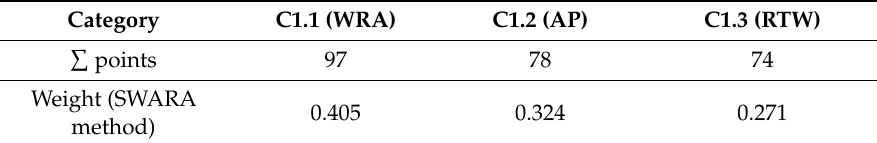
Table 9. Wastewater coverage (WWC) for the period 2013–2017